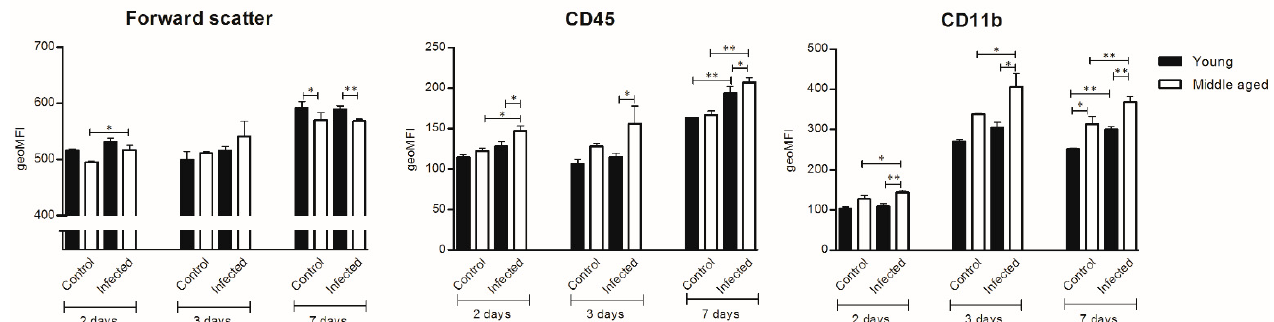
Figure 4. Geometric means (geoMFI) for forward scatter, expression of cluster of differentiation 45 (CD45) and CD11b measured with flow cytometry. Mann–Whitney U tests were performed. Data represent median ± IQR, * p ≤ 0.05, ** p ≤ 0.01. NB: Flow cytometry for every time point was done on a different day. Laser characteristics vary per day, and there- fore the geoMFIs are not comparable between the different time points. As such, every infected group ( n = 5) has its own control group ( n = 3 for 2 and 3d time points and n = 5 for 7d time point).